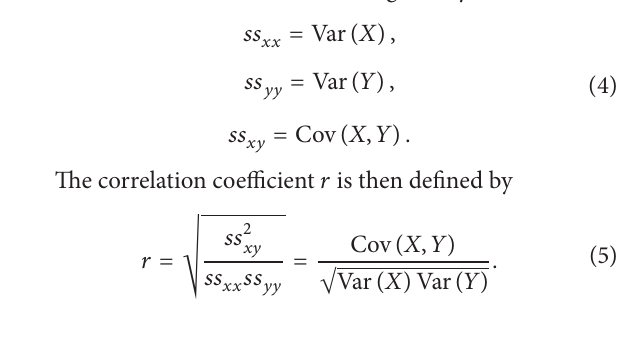
exists between the two data sets, the correlation coefficient will be